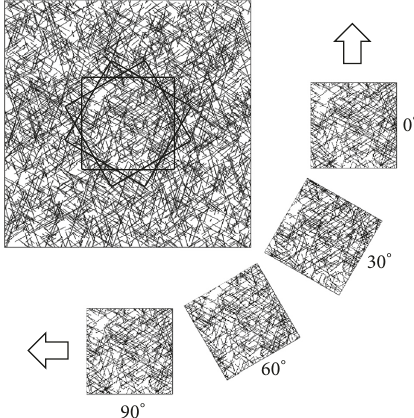
Figure 16: Generation of the fracture network and the rotated models.